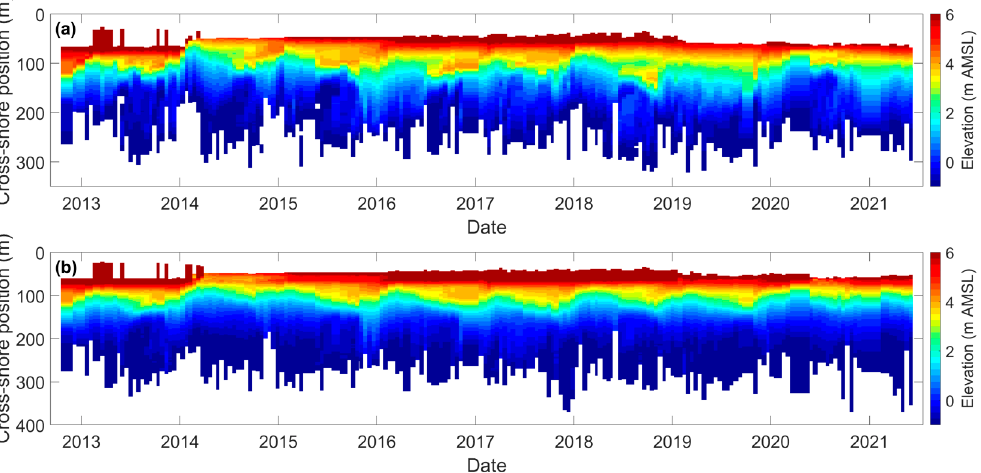
Figure 4. Cross-shore profile evolution (elevation colored) from 17 October 2012 to 10 June 2021. ( a ) Single profile located in the center of the domain and ( b ) alongshore-averaged profile.